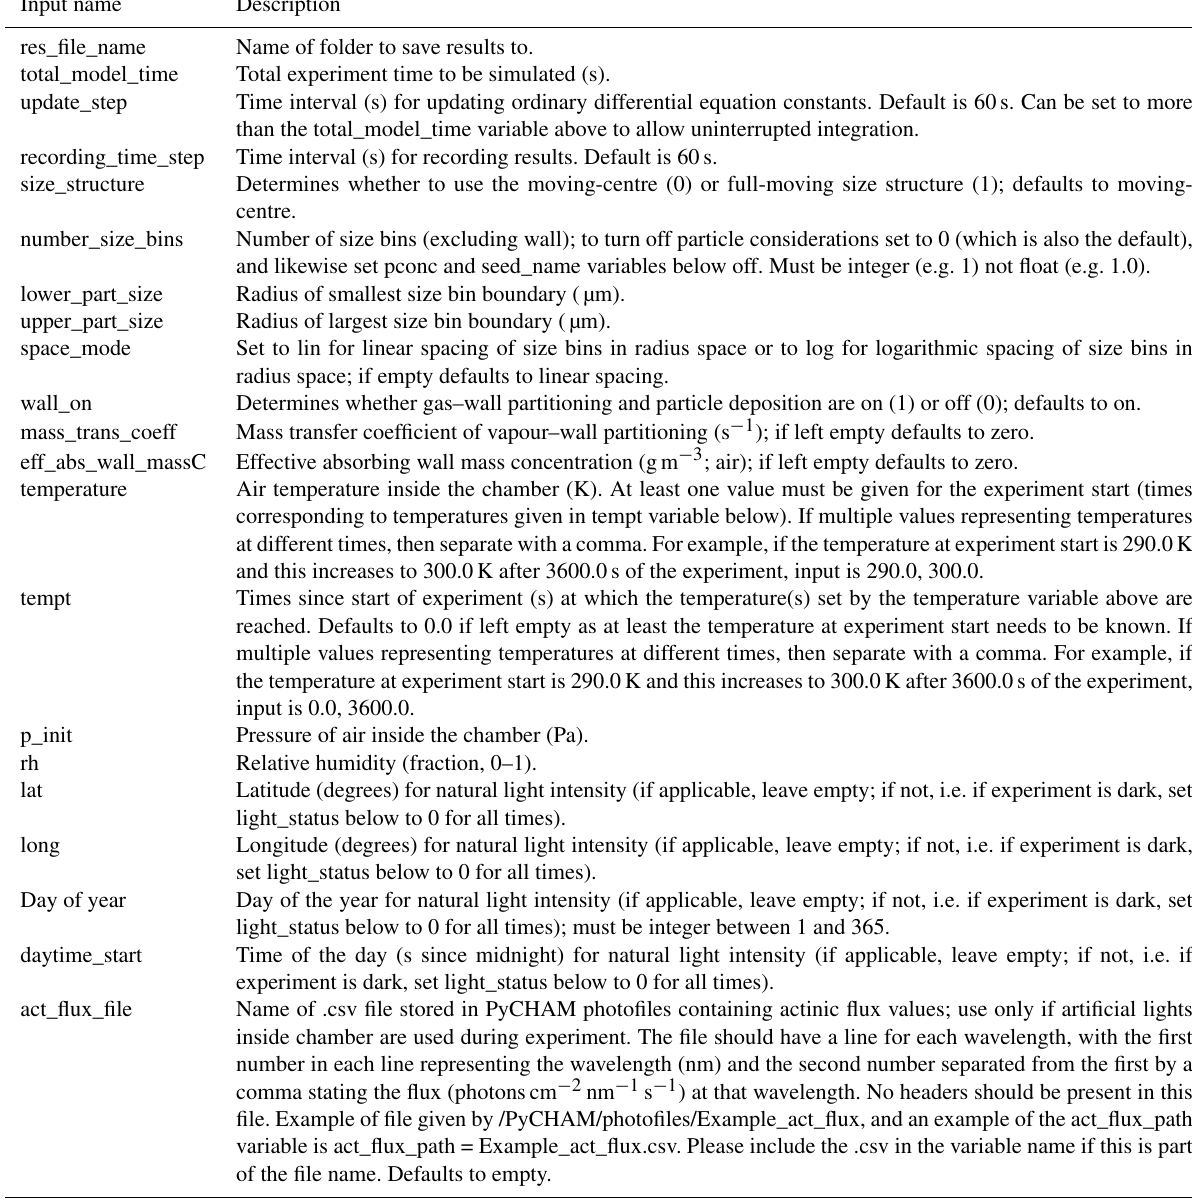
Table A1. PyCHAM variable inputs and their associated